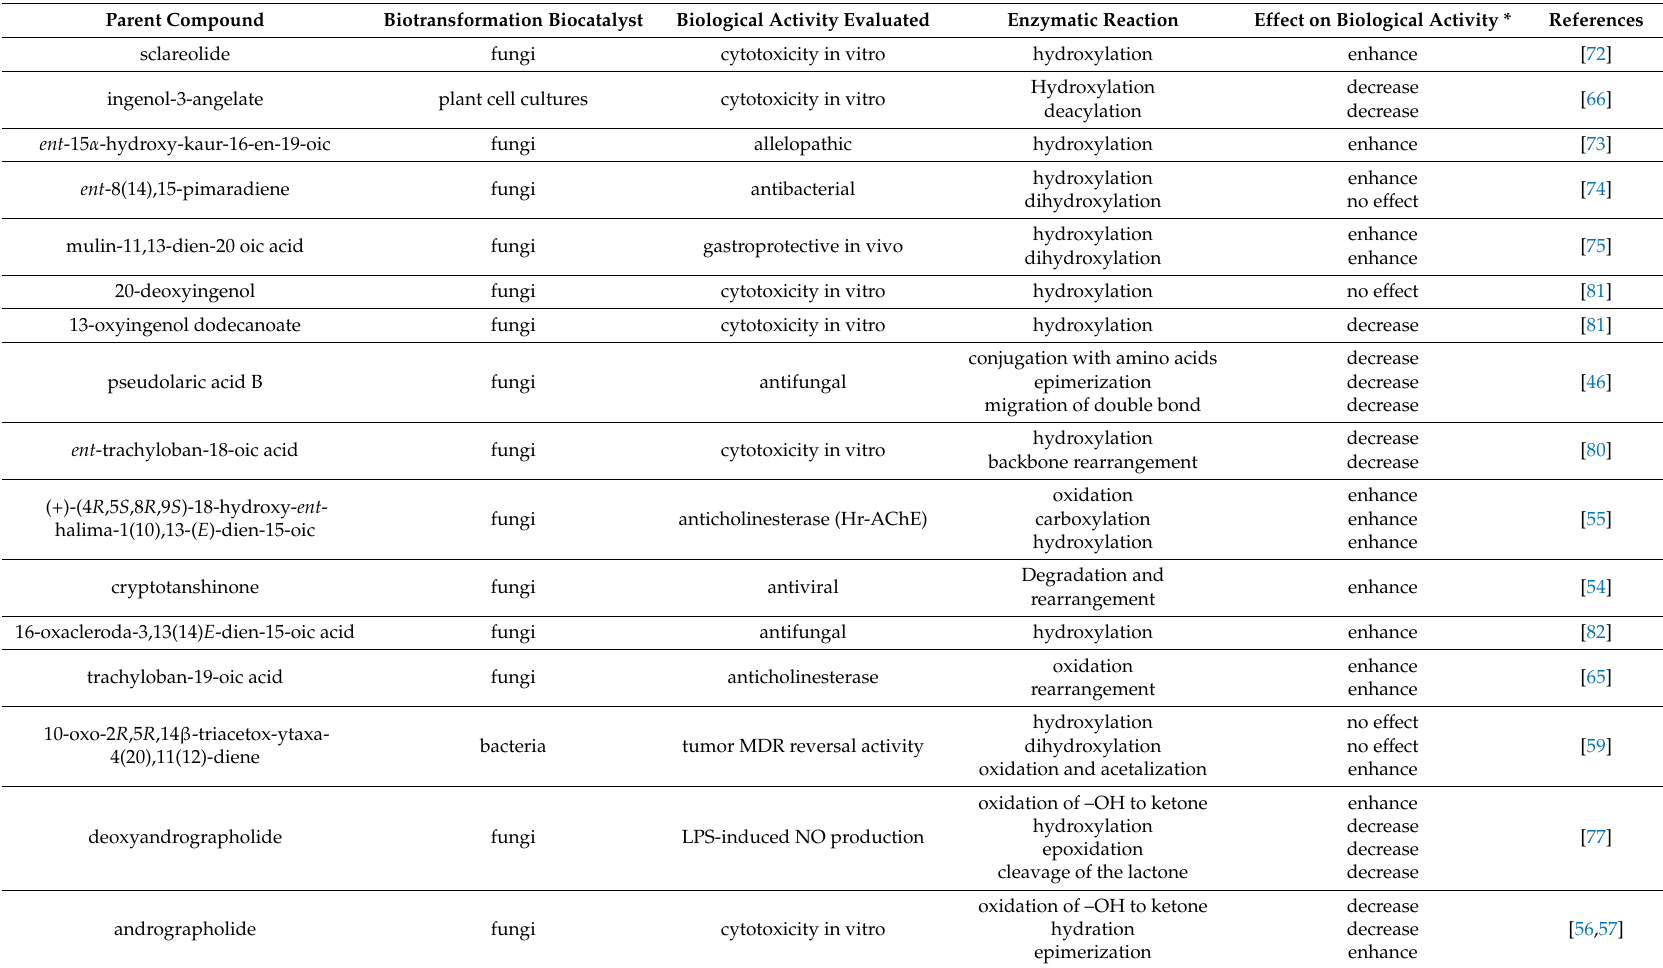
Table 1. Effects of biotransformation on the biological activities of different